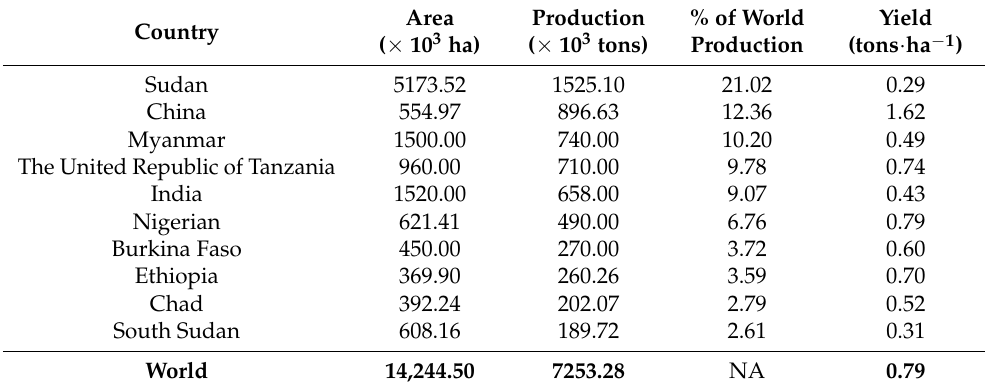
Table 2. The top 10 sesame-producing countries in 2020 with the total area, production, and yield globally. Country